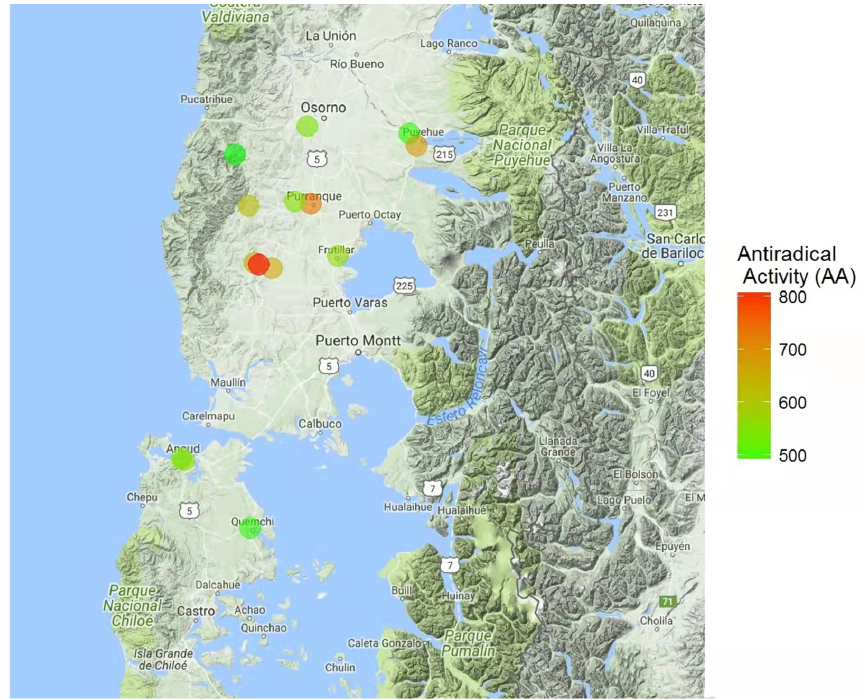
Figure 3. Map of the Los Lagos Region (Chile, 39 ◦ 16 (cid:48) S to 44 ◦ 04 (cid:48) S) indicating the sampled hive locations and respective antiradical activity of honey samples. Antiradical activity is indicated by a color scale going from green (lower activity) to red (higher